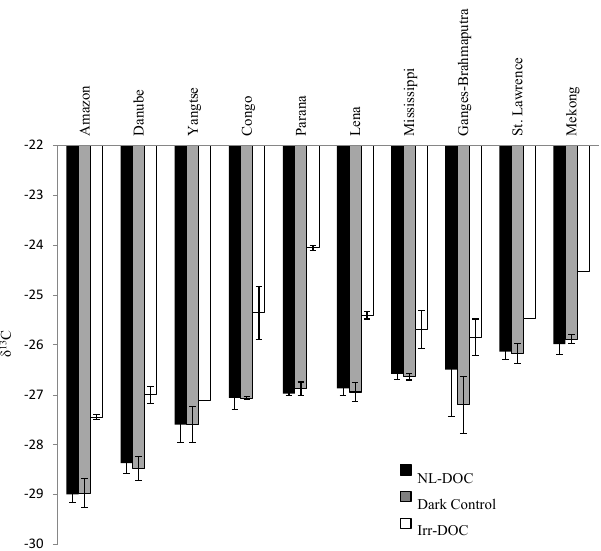
Figure 4. The isotopic signature ( δ 13 C) in the initial NL-DOC, in the irradiated NL-DOC (Irr-DOC) and in the dark control NL-DOC (Dark Control). The error bars show standard deviations of mea- surements ( n =